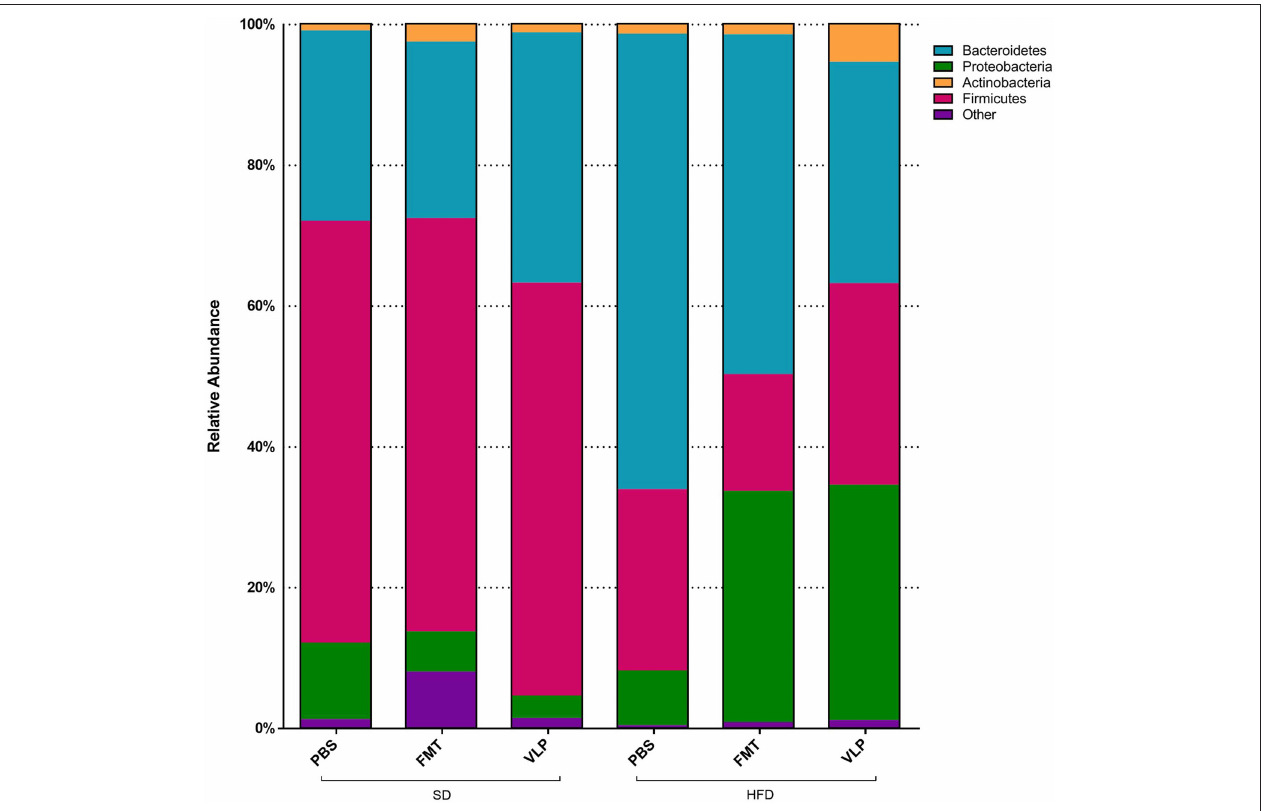
FIGURE 8 | Proportional representation of major bacterial phyla for each dietary-treatment group based on 16s amplicon sequencing results.